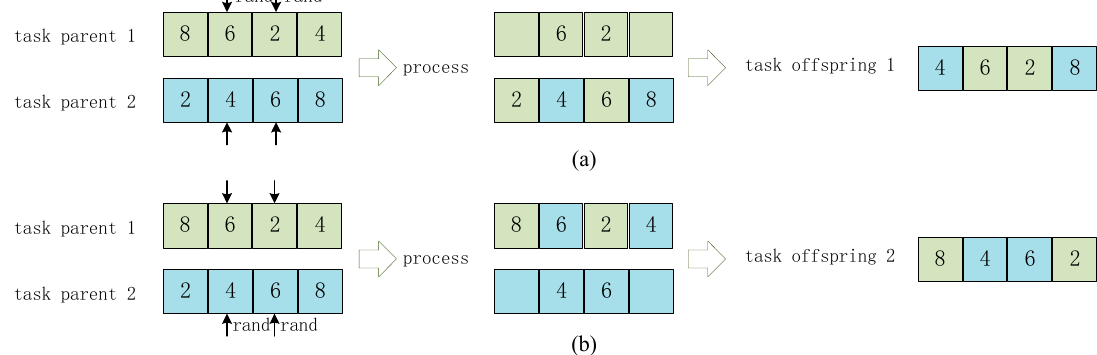
Figure 4. Crossover of the task chromosomes. ( a ) the first chromosome produced by crossover; ( b ) the second chromosome produced by crossover.